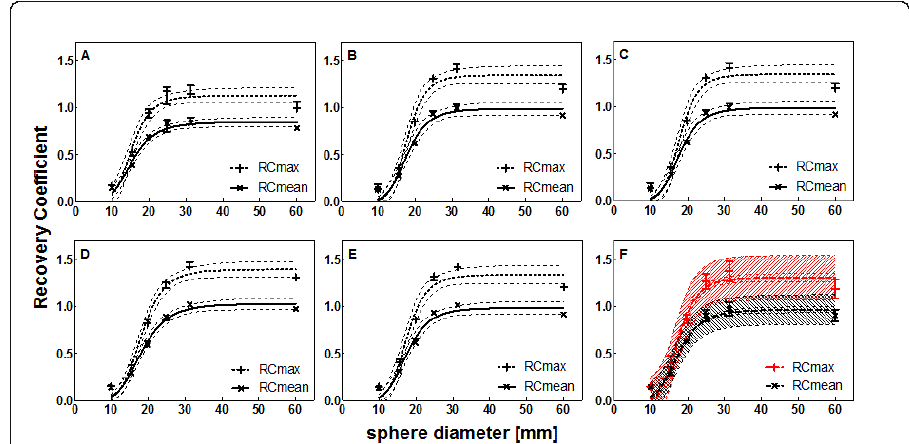
Fig. 5 Recovery coefficient as a function of sphere diameter for all systems separately ( a – e ) and for all systems combined ( f ), for data reconstructed with a vendor-neutral algorithm. Median and range of three repetitive measurements per system. a Discovery NM/CT 670 Pro. b Symbia Intevo Bold with xSPECT Quant. c Symbia Intevo Bold with Broad Quantification. d Symbia T16 system 1. e Symbia T16 system 2. f Mean and standard deviation for all systems combined. All data were fitted with a 3-parameter logistic function (dashed line 95% CI), for the combined data ( f ) also the 95% prediction interval is indicated (dashed area)